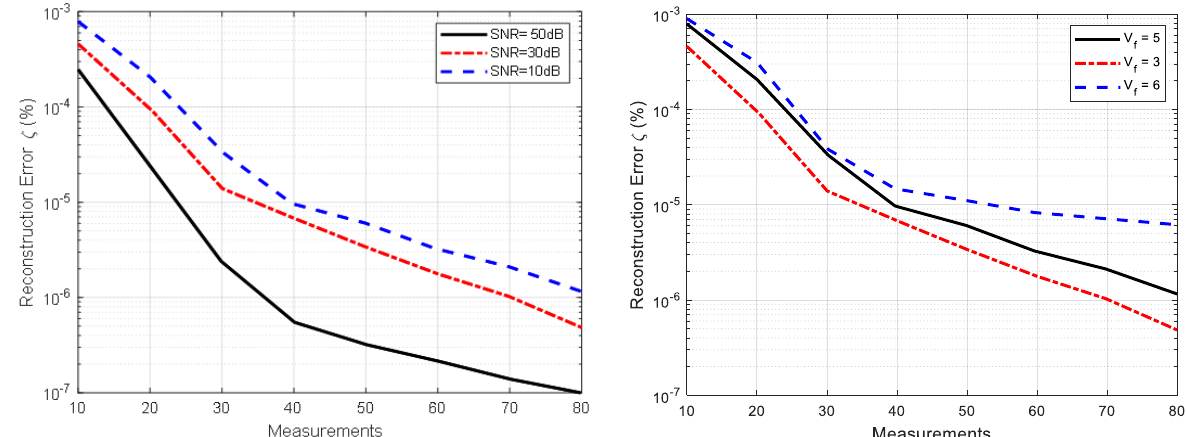
FIGURE 6. Reconstruction error versus measurements for different SNR. FIGURE 7. Reconstruction error versus measurements for different number of failure.